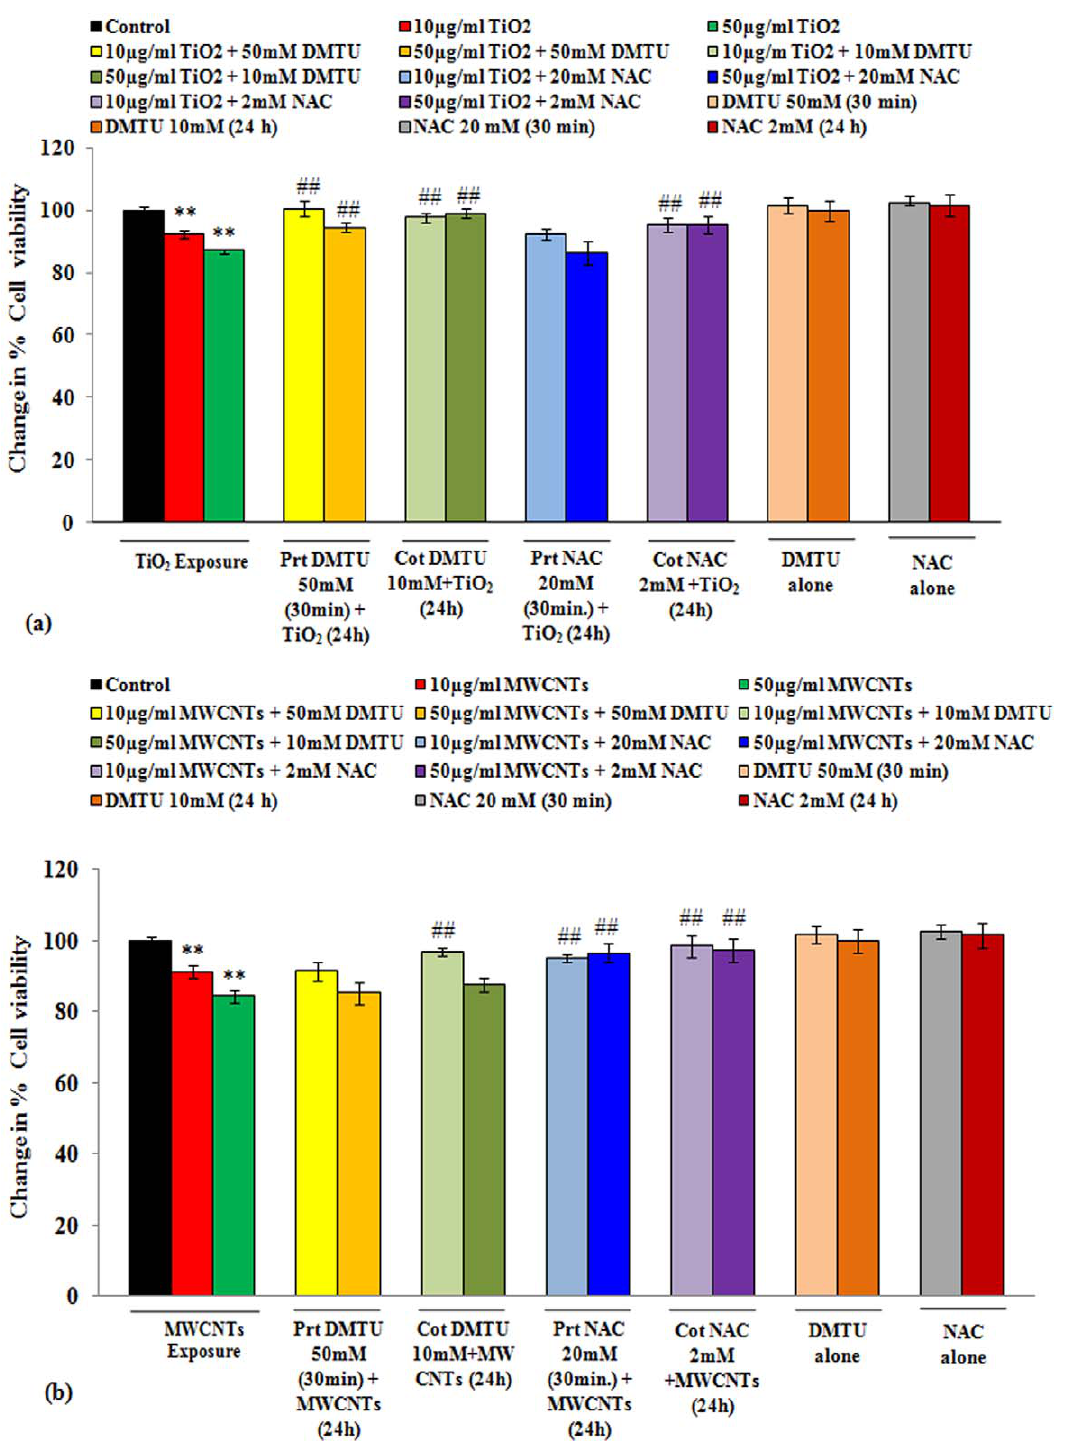
Figure 3. Cell viability restoration by DMTU and NAC in human lung cancer cells-A549 receiving the exposure of TiO 2 -NPs or MWCNTs. ( a ) In short term group, cells were pre-treated with either of DMTU or NAC for 30 minutes followed by exposure of TiO 2 -NPs (10 & 50 m g/ ml) for 24 h. In long term group, cells were receiving a co-exposure (24 h) of DMTU/NAC and TiO 2 -NPs (10 & 50 m g/ml). Cells were then analyzed for DMTU/NAC mediated restoration in the cell viability reduced due to TiO 2 -NPs exposure. All values are mean 6 S.E. of 3 experiments. ** P , 0.01 (unexposed control Vs TiO 2 -NPs exposure). ## P , 0.01 (TiO 2 -NPs exposure Vs DMTU/NAC treatment). ( b ) In short term group, cells were pre-treated with either of DMTU or NAC for 30 minutes followed by exposure of MWCNTs (10 & 50 m g/ml) for 24 h. In long term group, cells were receiving a co- exposure (24 h) of DMTU/NAC and MWCNTs (10 & 50 m g/ml). Cells were then analyzed for DMTU/NAC mediated restoration in the cell viability reduced due to MWCNTs exposure. All values are mean 6 S.E. of 3 experiments. ** P , 0.01 (unexposed control Vs MWCNTs exposure). ## P , 0.01 (MWCNTs exposure Vs DMTU/NAC treatment).